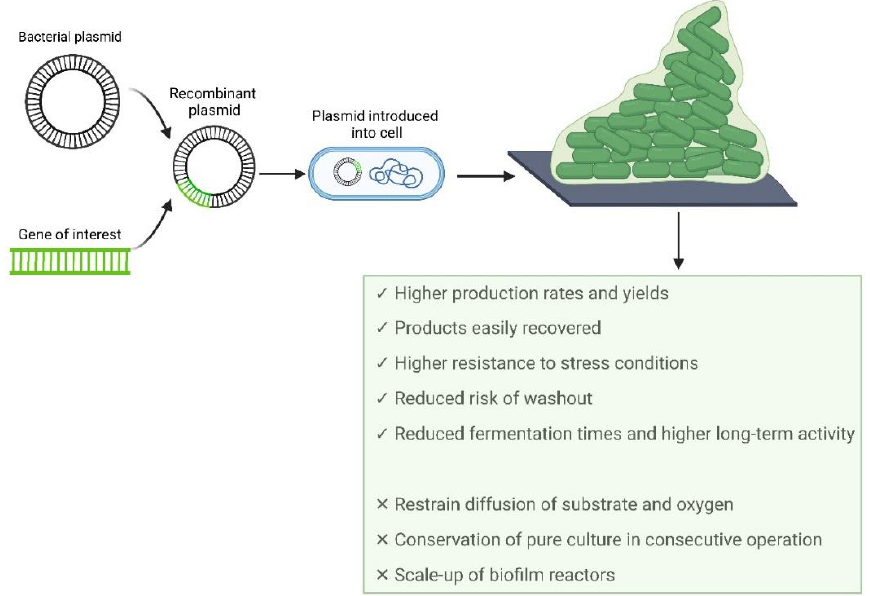
Figure 2. Production of recombinant proteins in biofilms: advantages and limitations.